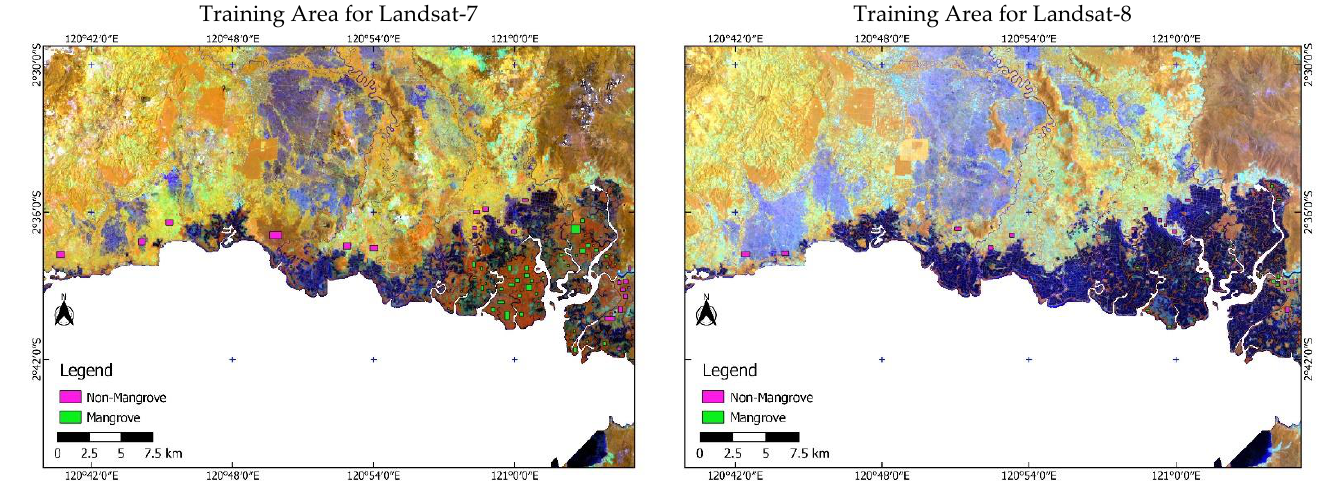
Figure 4. Distribution of training area for random forest algorithm in Landsat-7 and Landsat-8.